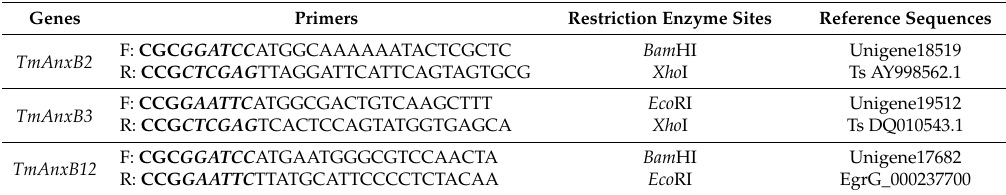
Table 1. Primers used for PCR amplification of Taenia multiceps annexins